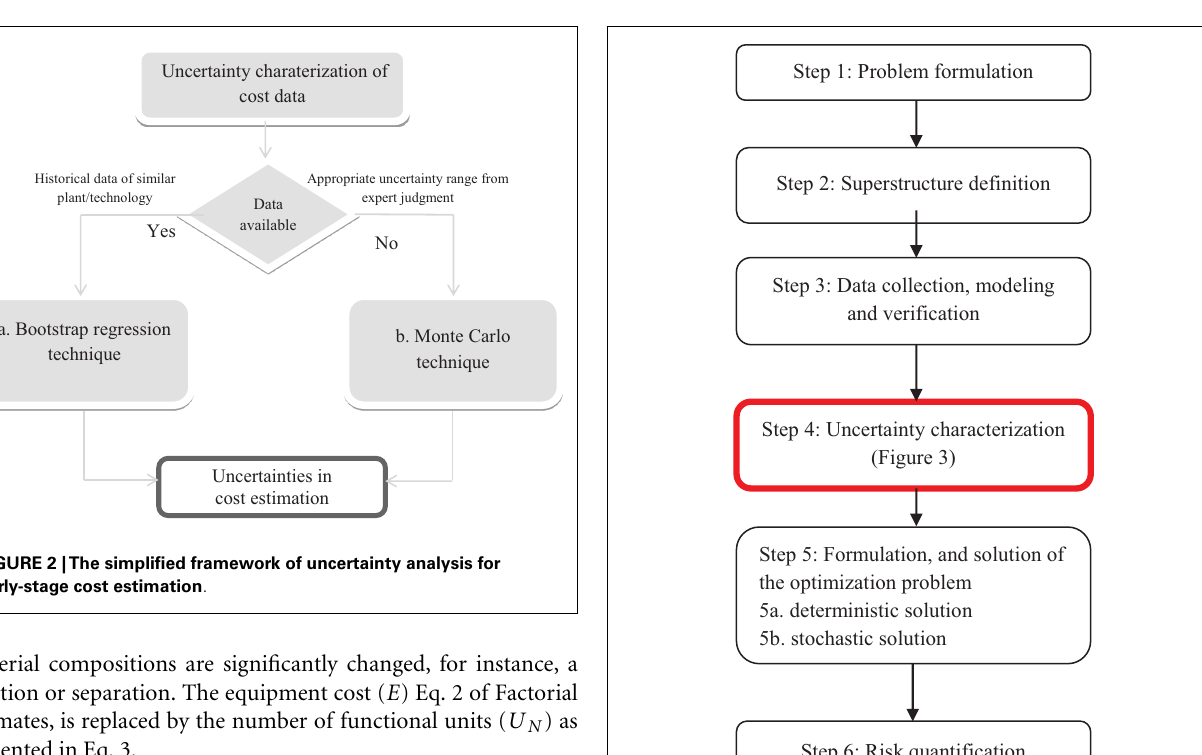
Model 3: pay-back method (production rate, raw material, and product price)